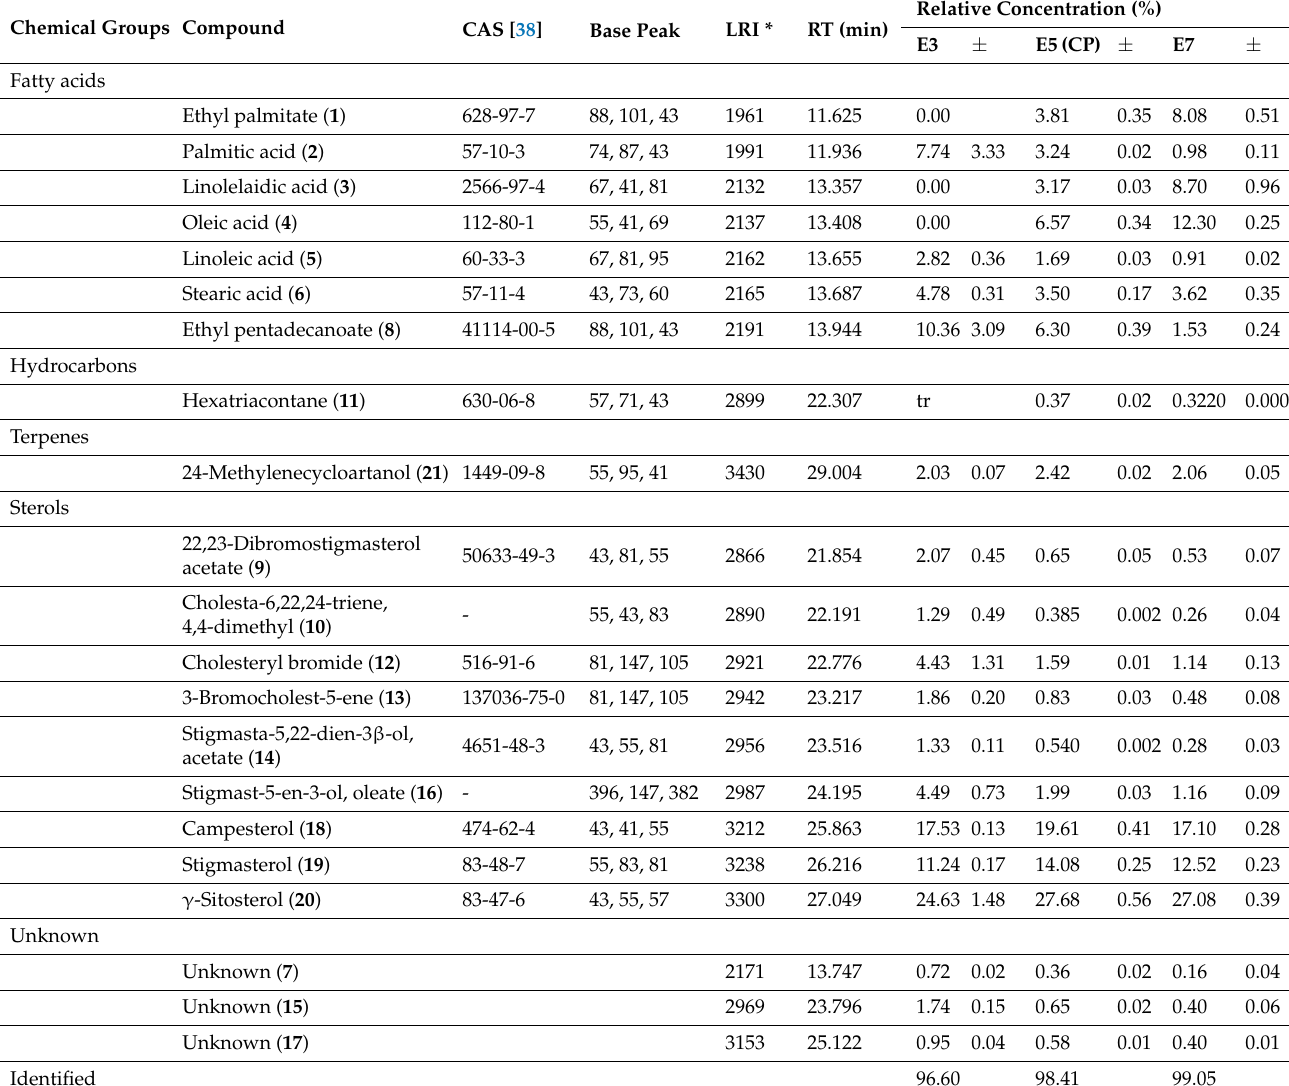
Table 5. Chemical composition of SFE-CO 2 extracts obtained from Mo roots and analysed by